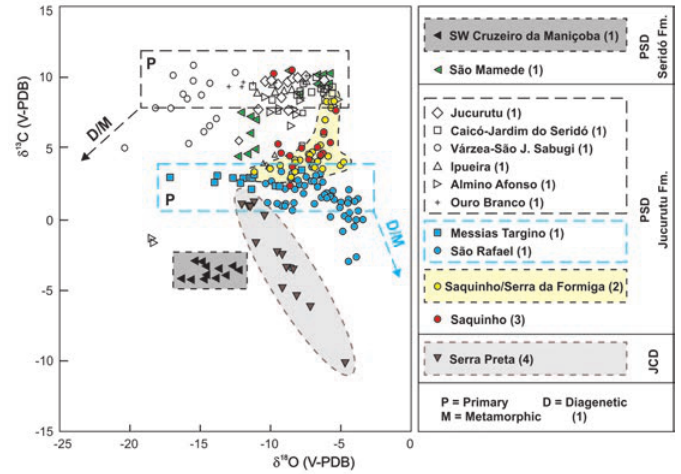
Figure 11 - Distribution diagram of O and C isotope compositions of the marbles of the Rio Piranhas-Seridó/PSD Domain (Jucurutu and Seridó formations) and the São José do Campestre/JCD Domain (Serra Preta/Serra Caiada Complex). Data source: (1) Nascimento et al. (2007) and Sial et al. (2015); (2) Campos (2011) and Sial et al. (2015); (3) this work; (4) Figueiredo